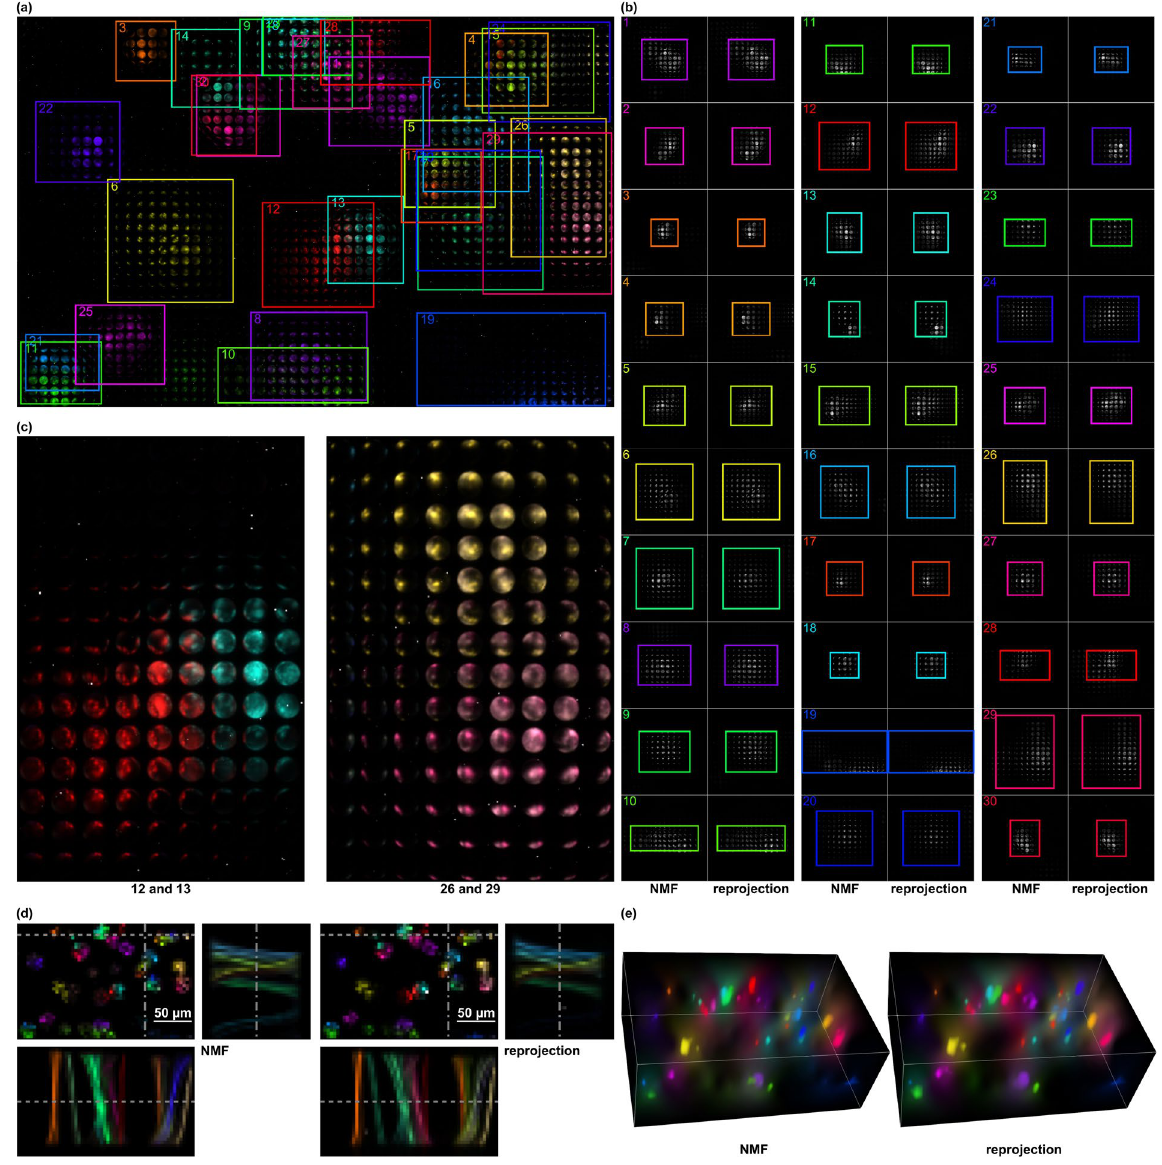
Figure 4. Measured CVLE results (after NMF; after reprojecting factorized signatures): ( a ) MLA image of color-coded particle light-fields after reprojecting their factorized signatures. ( b ) Close-ups of each particle signature. ( c ) Close-ups of overlapping signatures in ( a ). ( d ) Center light-field views with corresponding space- angle (epi) slices. Space-angle representation along dashed lines in center view indicates correct handling of occlusion cases (crossings of rays). ( e ) Volumetric renderings (perspective projection along axial direction of center view). The ACD between NMF and final results (reprojected factorized signatures) is 0.1177. Note, that a ground truth does not exist in this case. Measured results are also shown in the supplementary